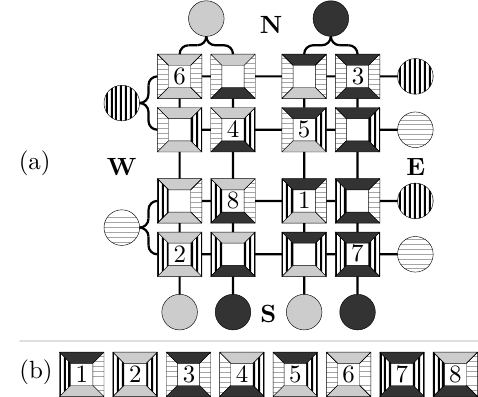
= 2, a) all possible i